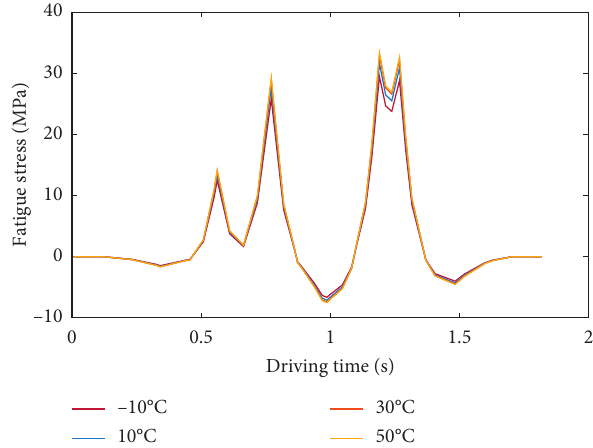
Figure 4: The fatigue stresses at different temperatures at moni- toring point B .